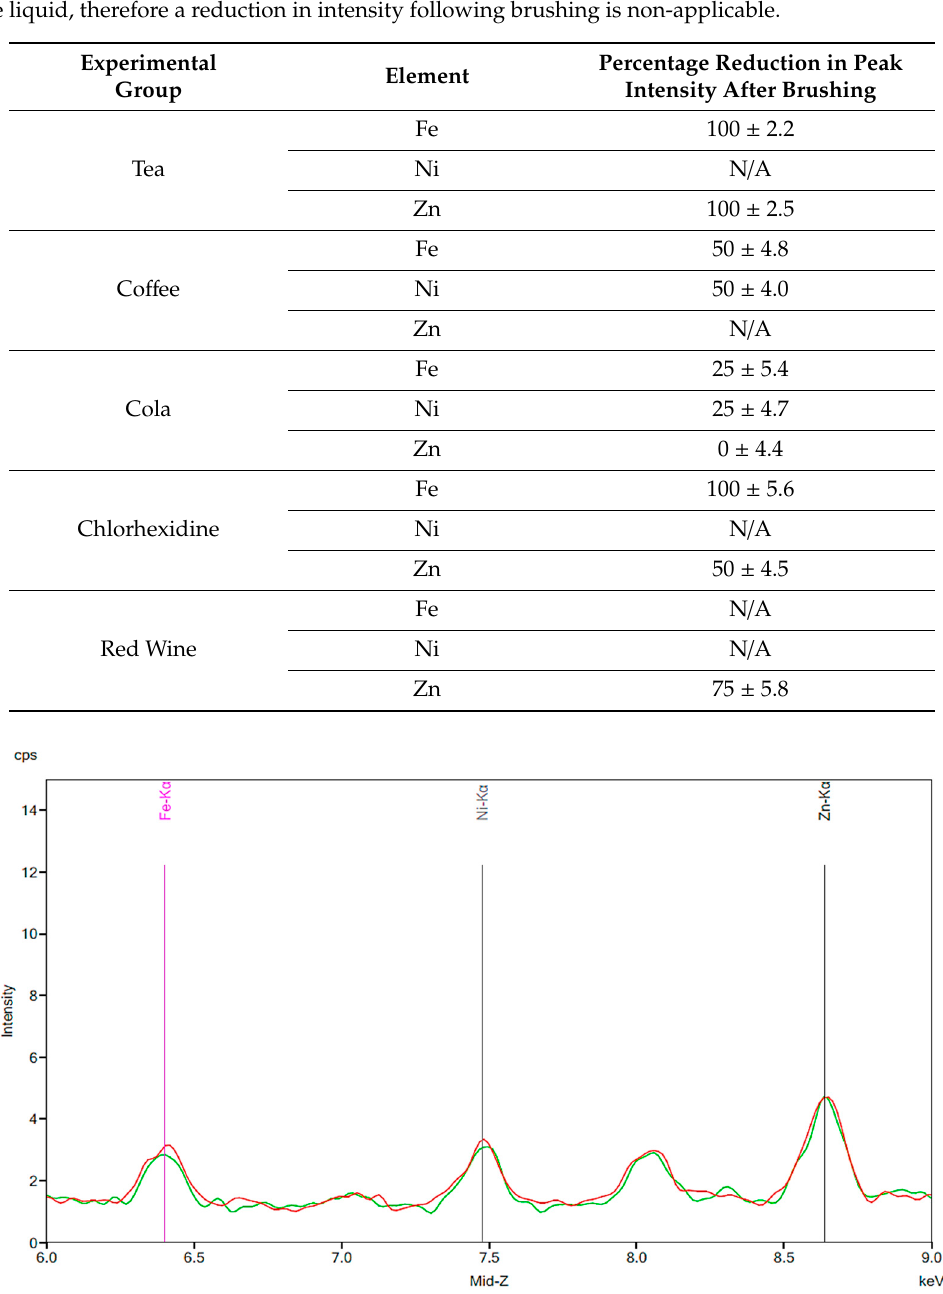
Figure 1. The results of the control group. The red peaks correspond to the baseline of the new artificial teeth prior to exposure to water. Markers are shown for iron, nickel and zinc. The green peaks represent the same artificial teeth following exposure to tap water for 24 h.